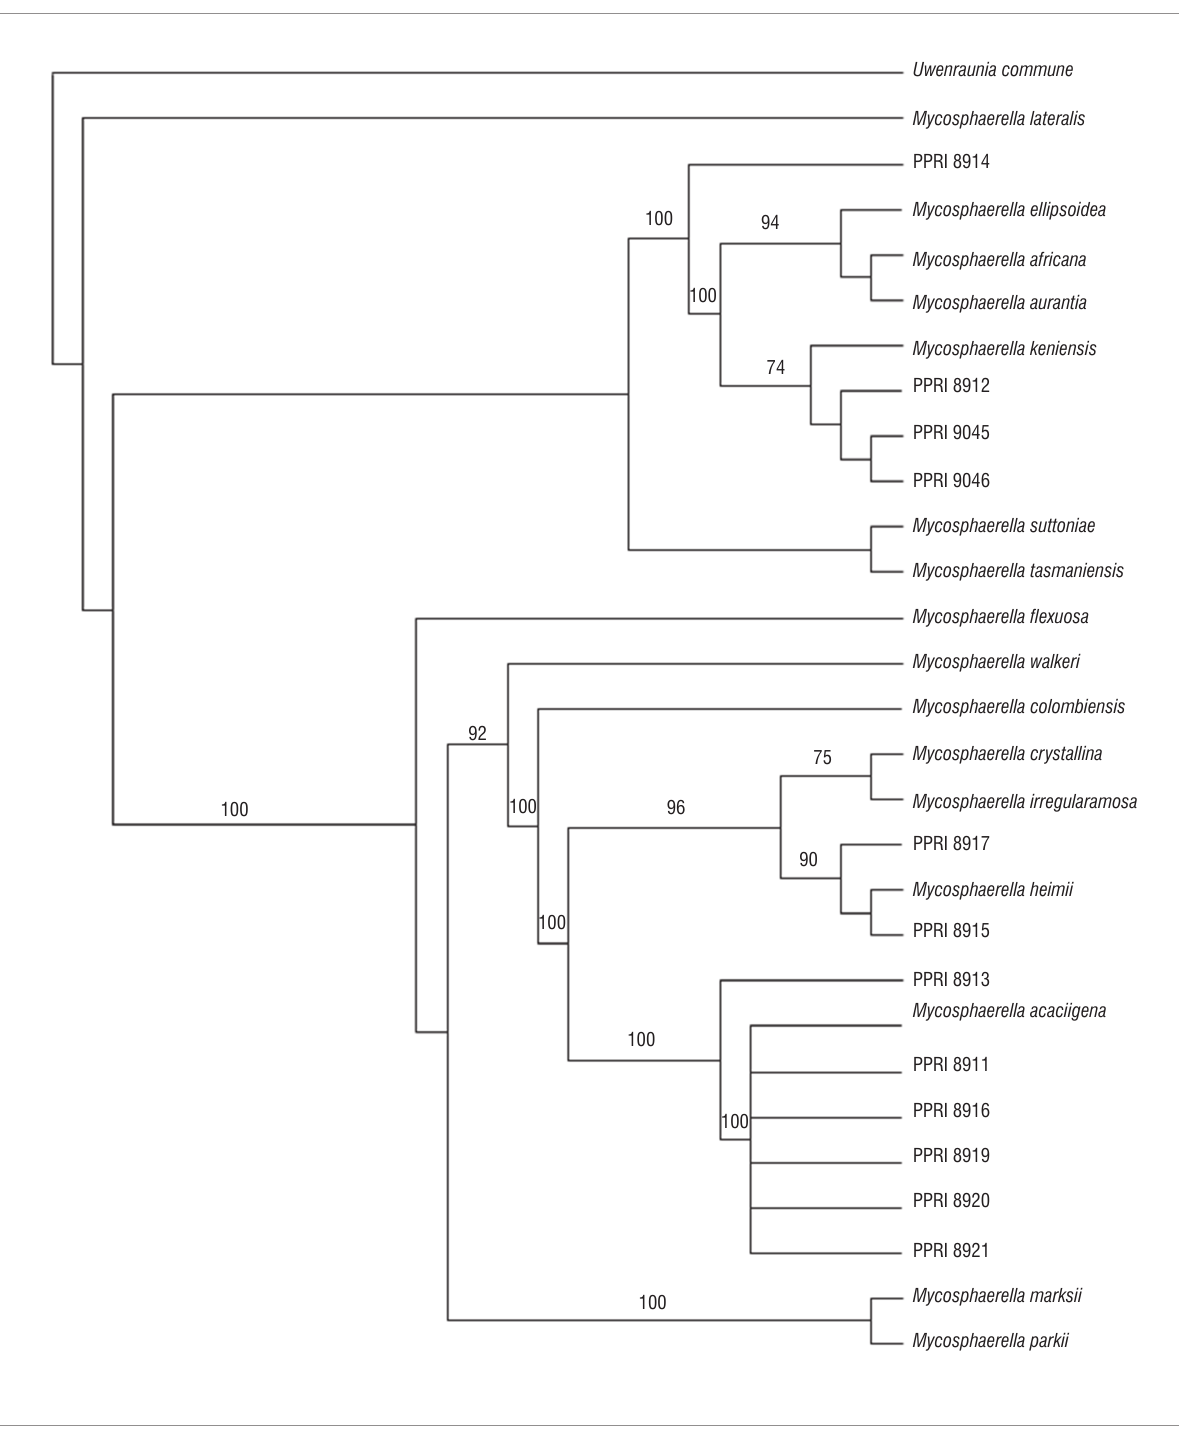
Figure 2: Phylogenetic tree produced using parsimony of the internal transcribed spacer and translation elongation factor 1 α gene regions with Uwebraunia commune as outgroup. Bootstrap values above 70% (percentages of 1000 bootstrap replicates) are indicated above the branches of the tree (tree length=483; consistency index=0.5983; retention